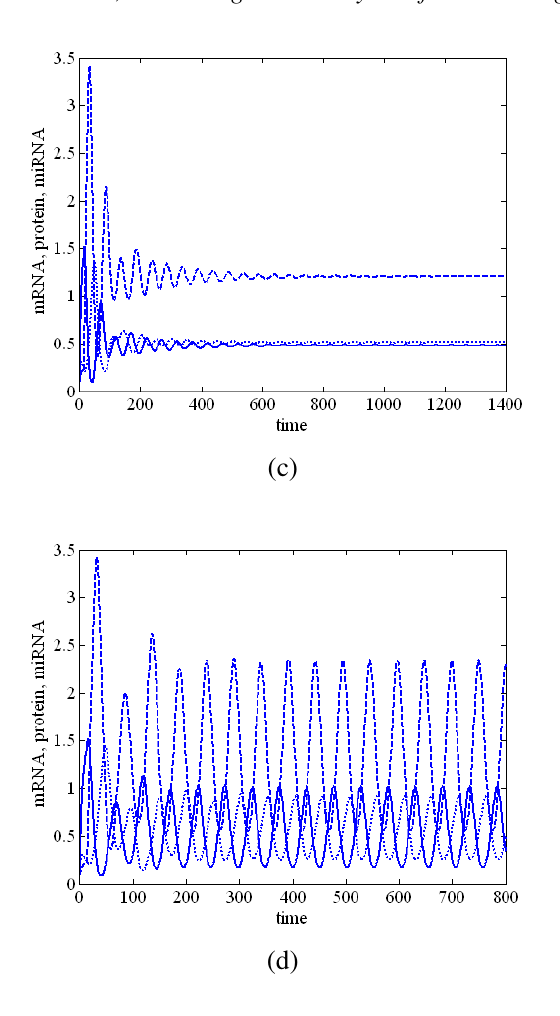
Fig. 4. Dynamic behaviour of system (2). Unsta- ble regime (periodic oscillations) for τ 1 = τ 3 = 0 , τ = 20 (a); and τ = 0 , τ = 13 , τ = 10 (b). 2 1 2 3 Stable regime for τ 1 = 1 , τ 2 = 13 , τ 3 = 37 (c). Unstable regime (sustained oscillations) for τ = 1 , τ = 13 , τ = 60 (d). 1 2 3